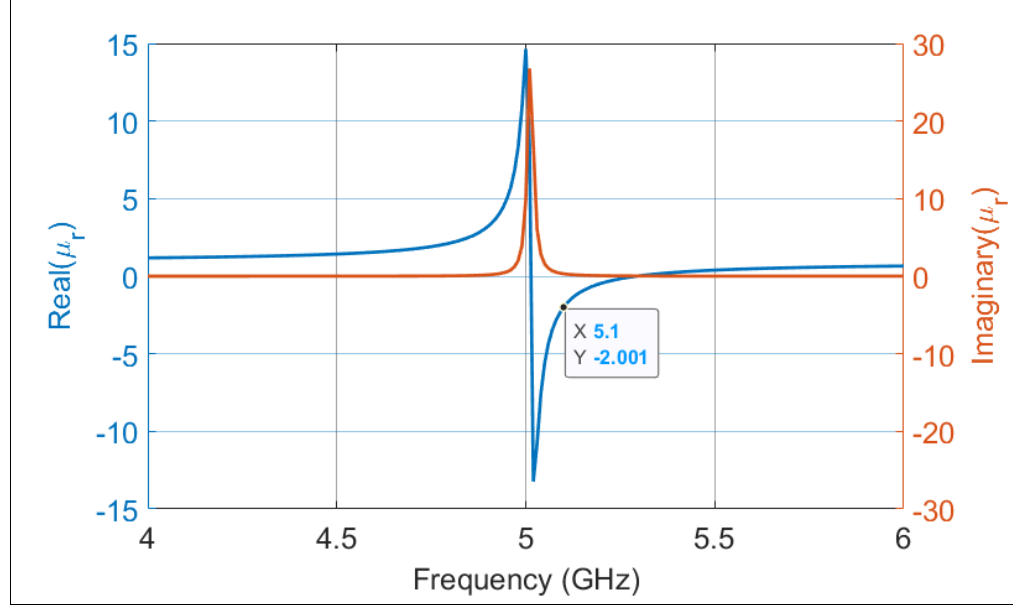
Figure 4. Real and imaginary parts of the relative permeability of a SRR